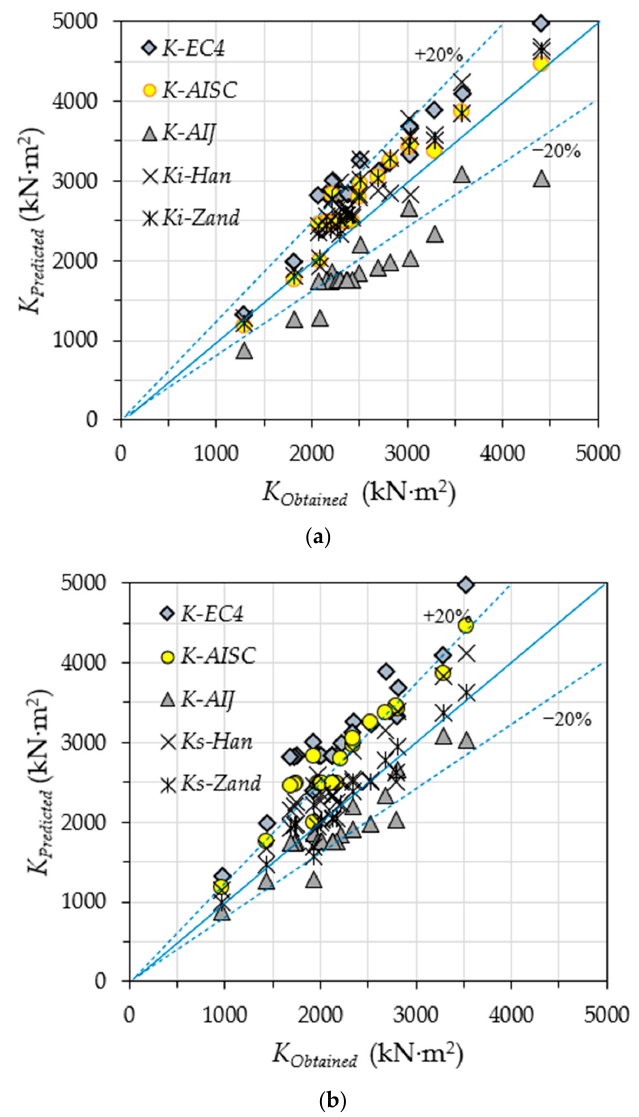
Figure 12. Verification of the obtained flexural stiffness: ( a ) Ki ; ( b ) K s .